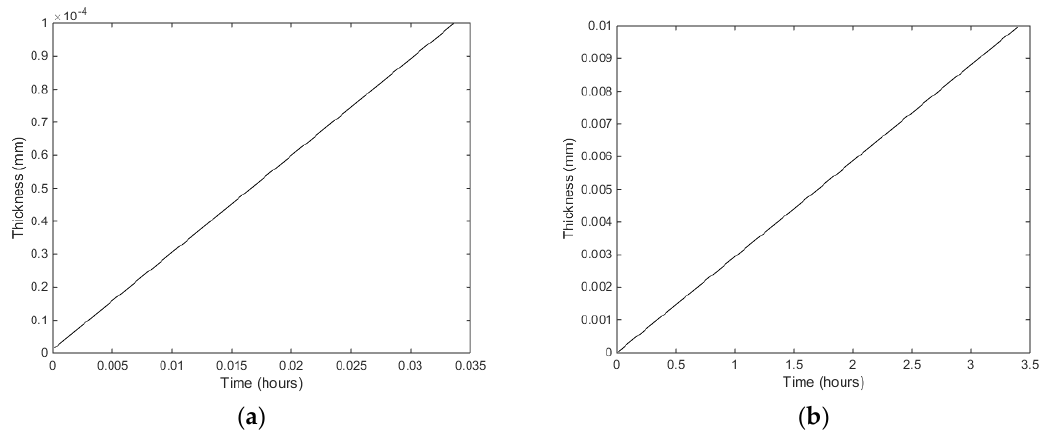
Figure 6. ( a ) Time to grow 100 nm CH 4 hydrate film. ( b ) Time to grow 10 micron hydrate